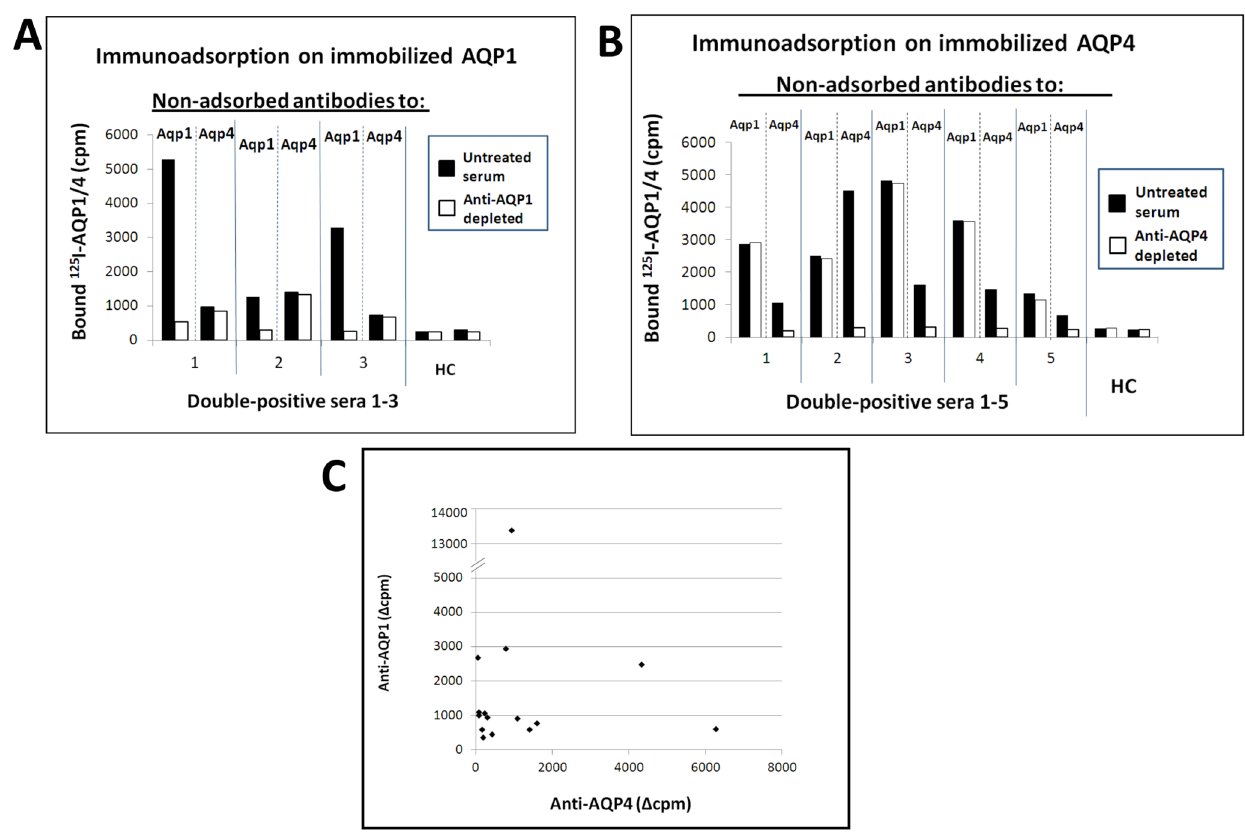
Figure 6. Anti-AQP1 antibodies and anti-AQP4 antibodies do not bind to the other antigen. ( A and B). Search for cross-reactivity of anti- AQP1 and anti-AQP4 antibodies with AQP4 and AQP1, respectively. Three (A) or five (B) double-positive serum samples were incubated with immobilized AQP1 (A) or AQP4 (B) to immunoadsorb the corresponding antibodies, then were tested by RIPA for binding to 125 I-labeled AQP1 or AQP4 (white bars) in parallel with the untreated sera (black bars). HC, healthy control. (C). Lack of correlation of the amount of radiolabeled AQP1 precipitated by anti-AQP1 antibodies (y axis) or AQP4 (x axis) precipitated anti-AQP4 antibodies by double-positive sera in identical regular RIPAs performed using the two labeled antigens. doi:10.1371/journal.pone.0074773.g006 from 100 healthy individuals and 142 patients with non- also confirmed by several competition experiments (Figure 3) and demyelinating neuroimmune diseases (131 with MG) (Figure 1). by the independent determination of autoantibody binding by The specificity of the anti-AQP1 antibodies in patients’ sera was Western blotting (Figure 4). Finally, although in general RIPAs are